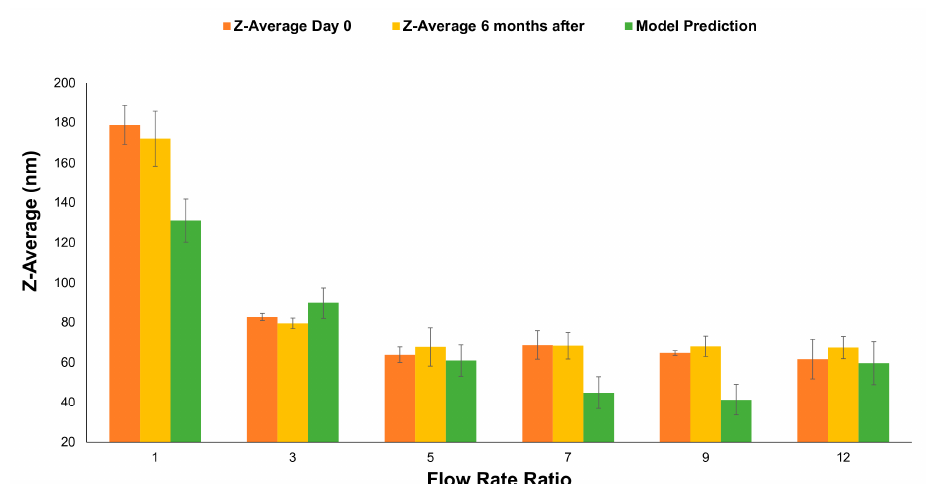
Figure 6. Z-average (nm) vs. FRR at a constant TFR = 18 mL / h. In orange, the Z-average immediately after production, in yellow six months after, and in green the model prediction. n = 3. Error bars indicate +/ − 1 standard deviation (SD) for samples and SE fit for the model prediction.